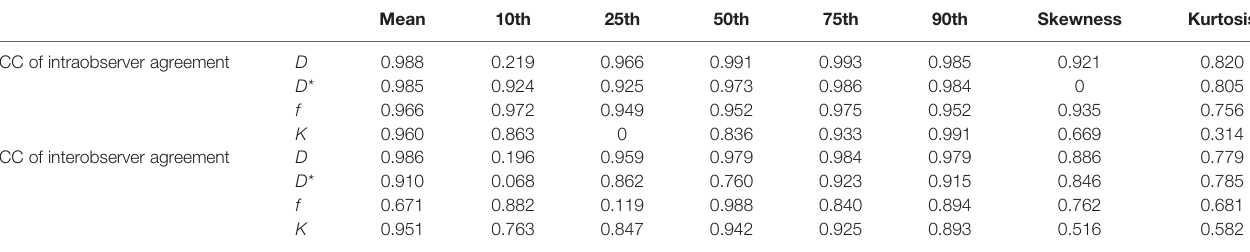
TABLE 2 | Intra- and interobserver agreement of mean values and histogram parameters for IVIM-Kurtosis model.